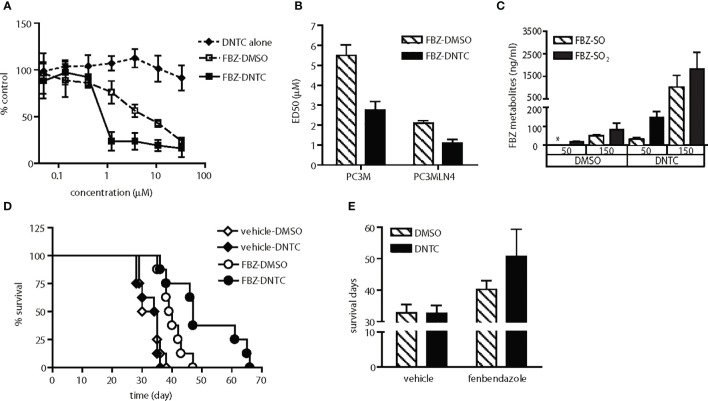
Enhanced anti-tumor activity of fenbendazole was observed upon improvement in solubility and bioavailability. (A) Fenbendazole (FBZ) cytotoxicity in PC-3MLN4 cells is shown for drugs solubilized in either DNTC or DMSO. DNTC itself exhibits minimal cytotoxicity. FBZ-DNTC and FBZ-DMSO were significantly more cytotoxic than DNTC alone, p<0.001 for doses ≥1 µM. (B) Comparison of ED50 of FBZ when formulated in the two different vehicles, DMSO and DNTC; p<0.001. (C) Measurement of FBZ and its active metabolites (FBZ-SO and FBZ-SO2) in the mouse plasma collected after one injection. FBZ was not detected in all samples. *, under limit of detection. (D) AT6.1 cells were inoculated intravenously 5 days prior to treatment of 100 mg/kg fenbendazole either in DMSO or DNTC, given 3 times a week until signs of morbidity were observed. Shown are Kaplan Meier survival curves of mice in each group. N=8 per group, p<0.001 in FBZ-DMSO vs. FBZ-DNTC. (E) Average of survival days for each treatment group from panel (D) Data shown are mean ± 95% confidence interval, N=8 per group, p<0.001.